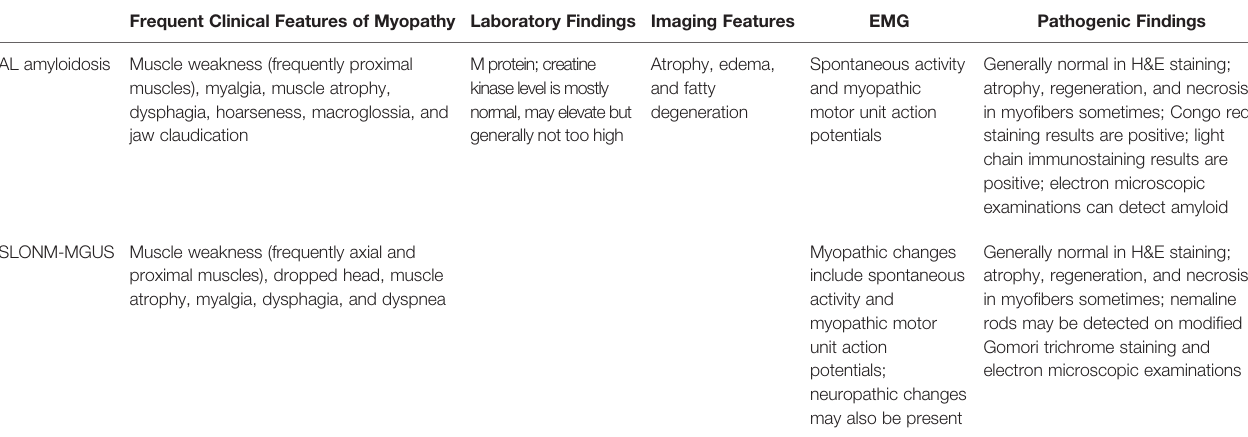
TABLE 1 | Features of MGCS-associated